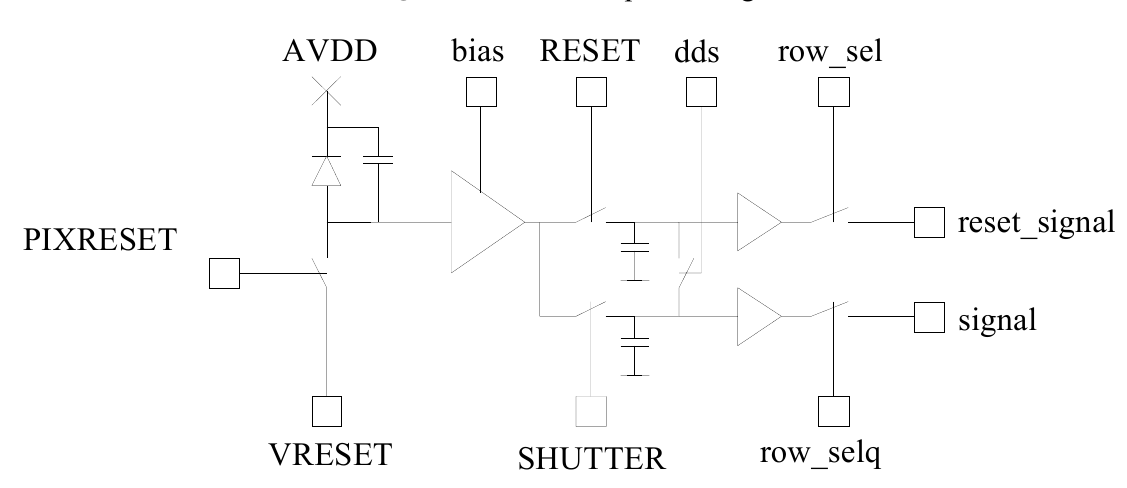
Figure 2. Schematic pixel